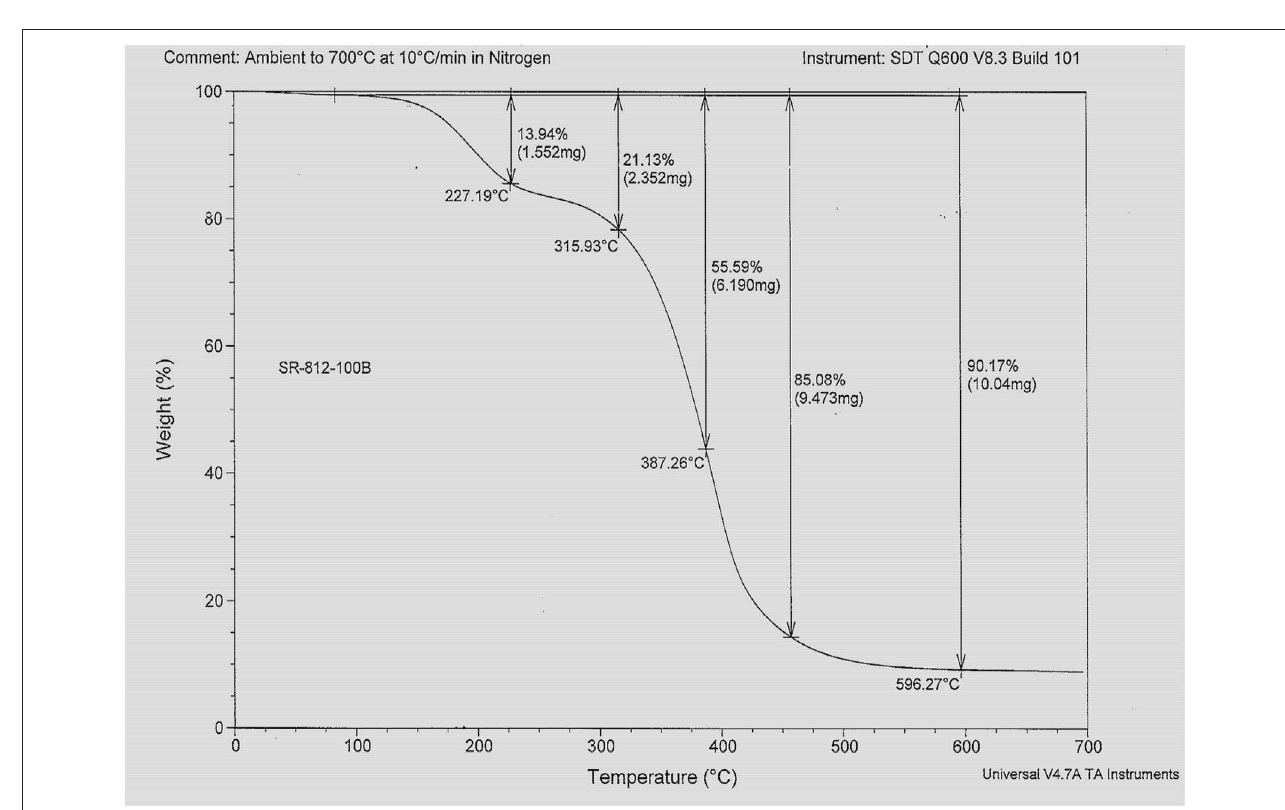
FIGURE 3 | TGA profile of hyper-branched polymer